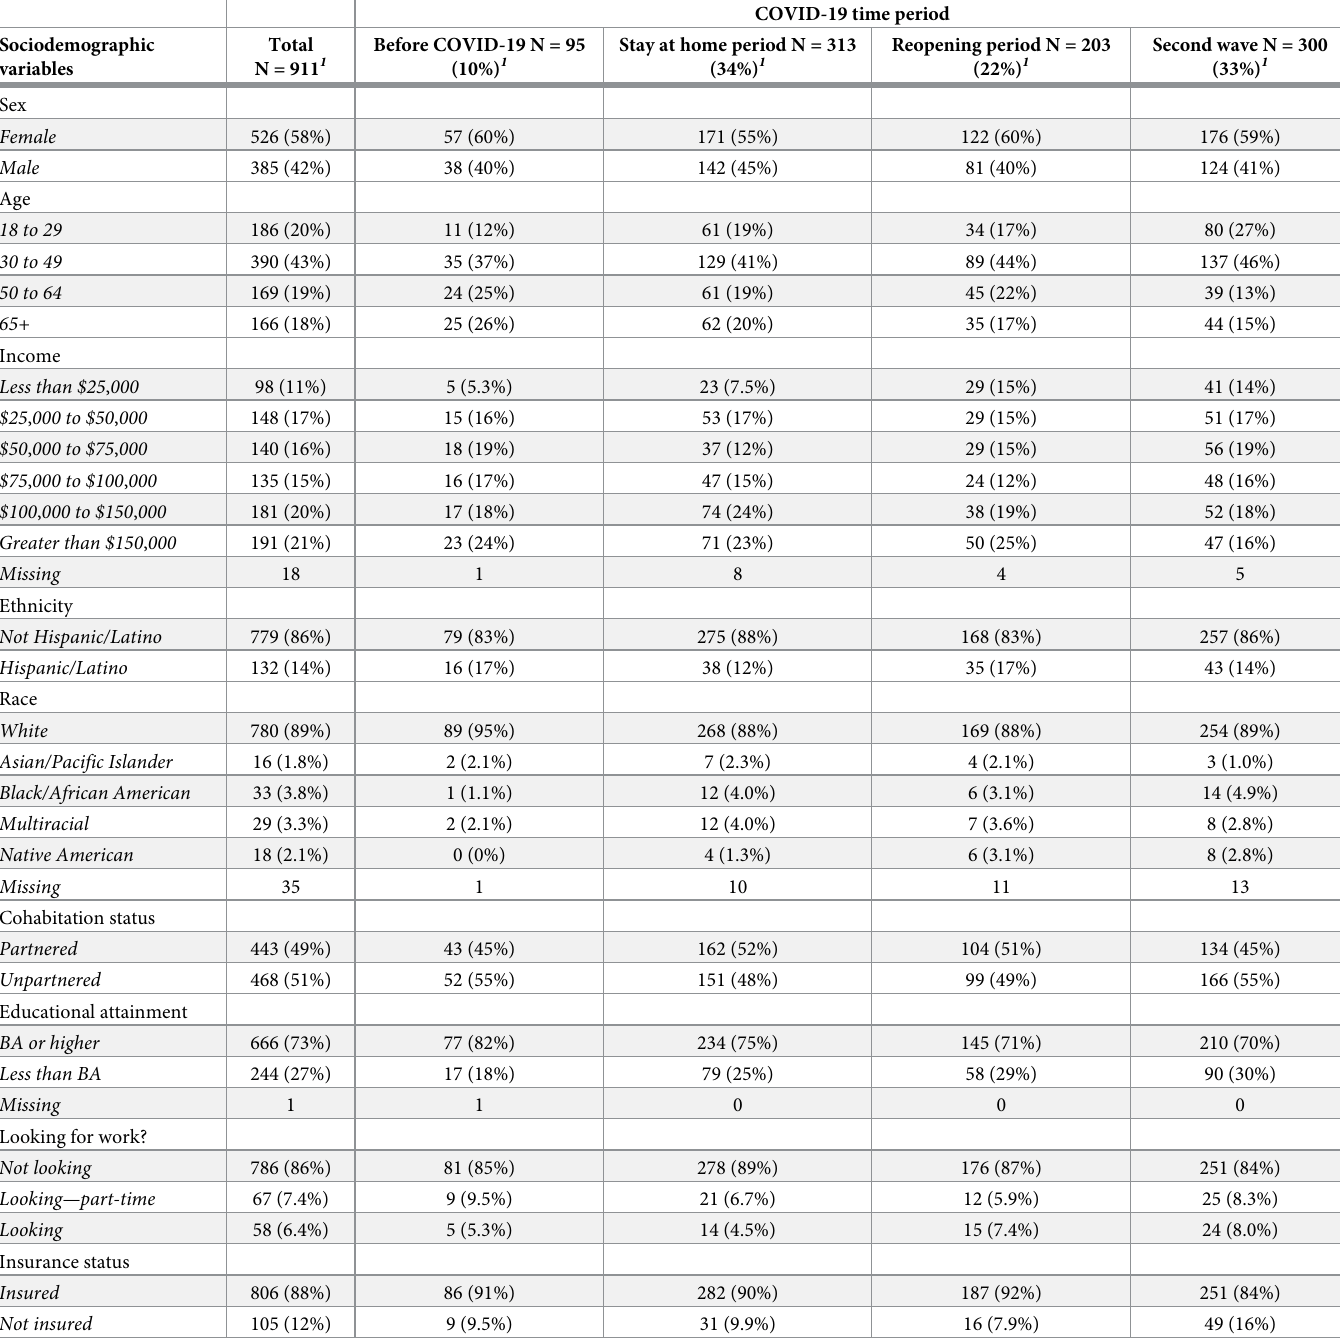
Table 1. Sociodemographic summary statistics for survey respondents.